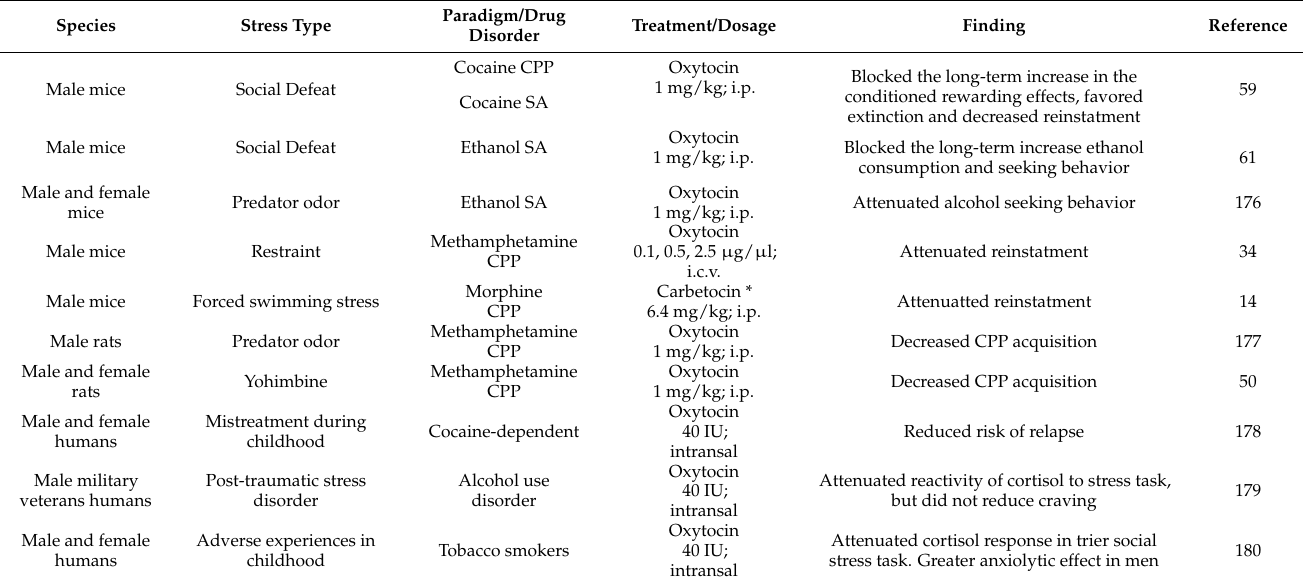
Table 1. Effect of the administration of oxytocin as a therapeutic target in the addictive process induced by social stress in animal models and clinical